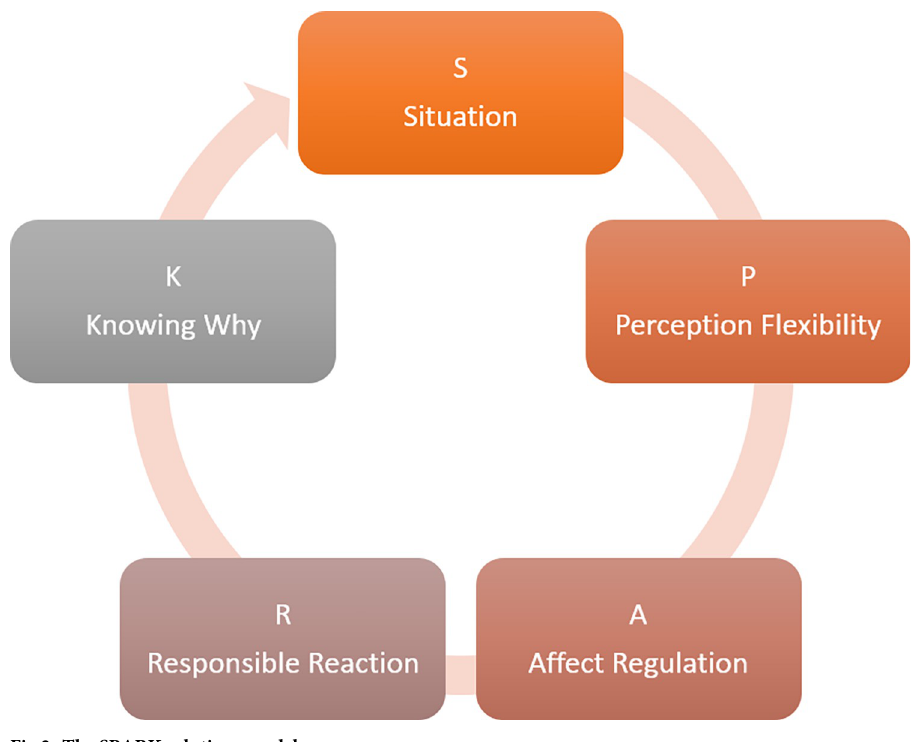
Fig 2. The SPARK solutions